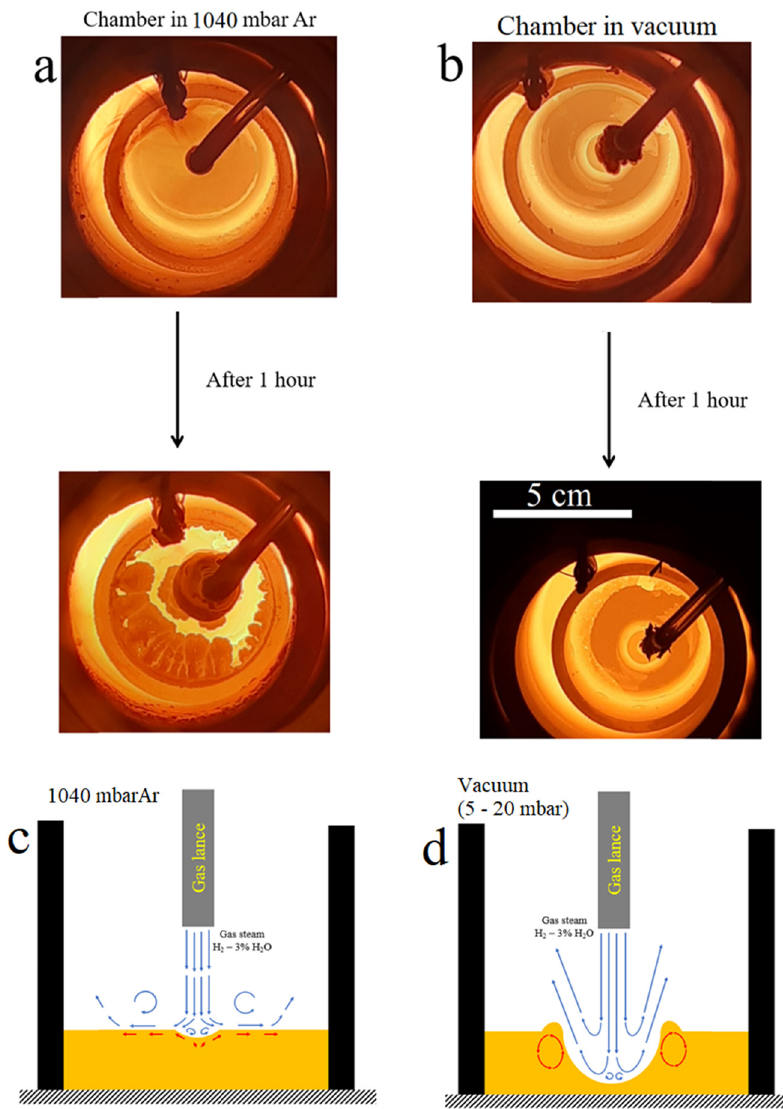
Figure 8: Photographs of the crucible during the ( vacuum ) re fi ning experiments. ( a ) and ( c ) Gas re fi ning in Ar atmosphere. ( b ) and ( d ) Gas re fi ning in